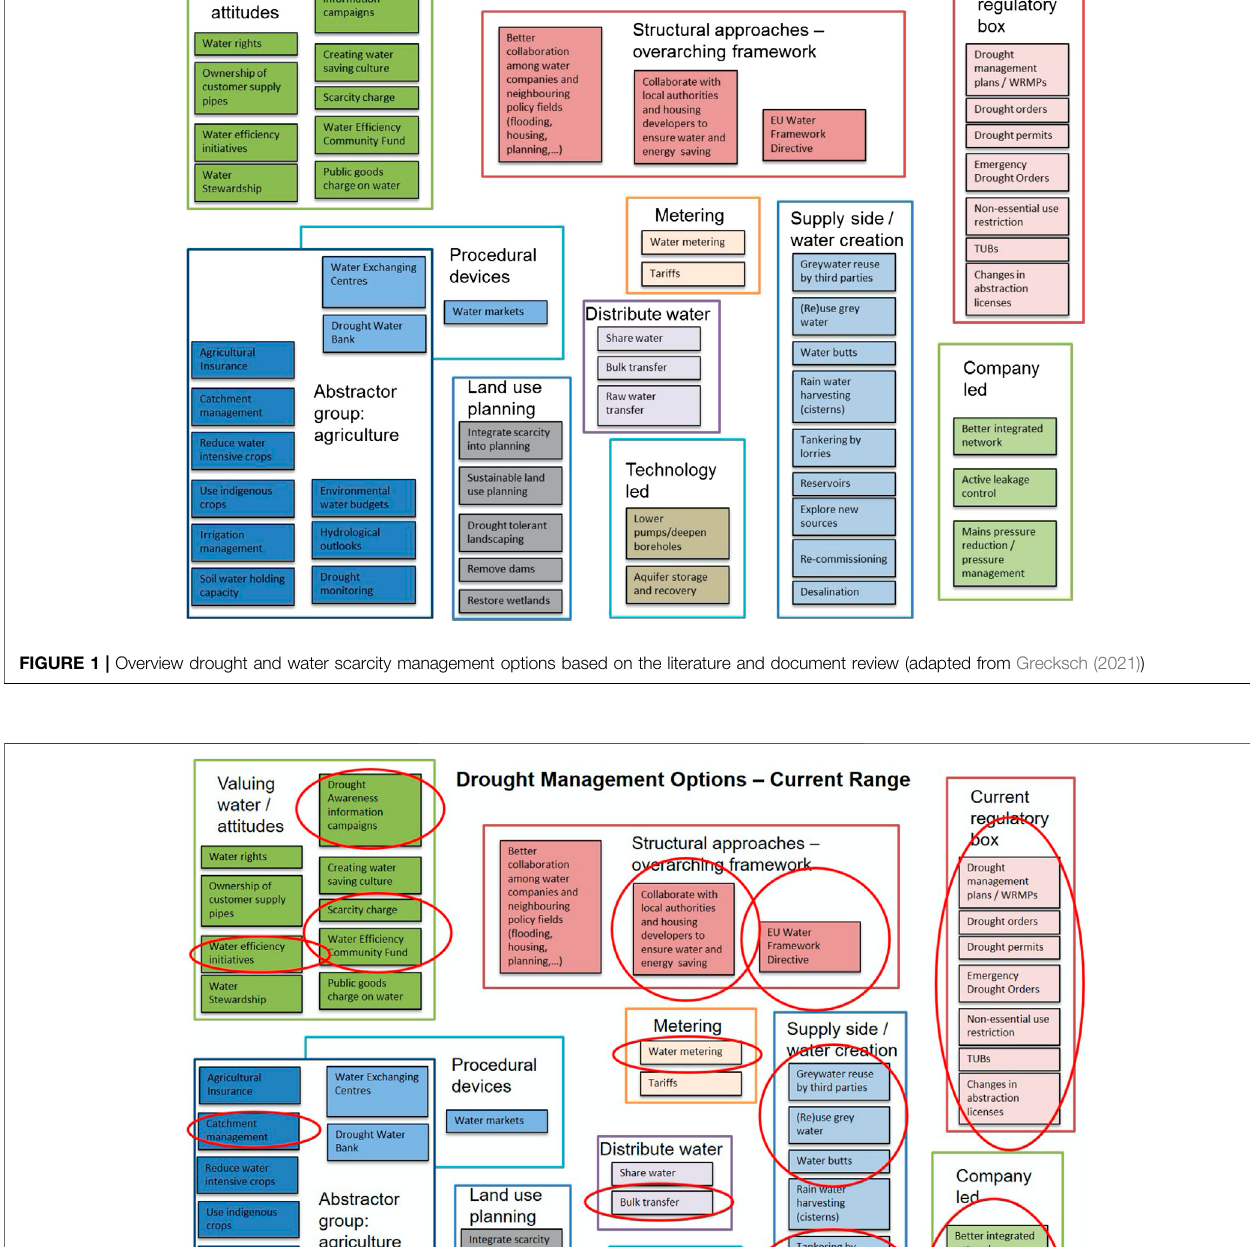
Frontiers in Environmental Science |